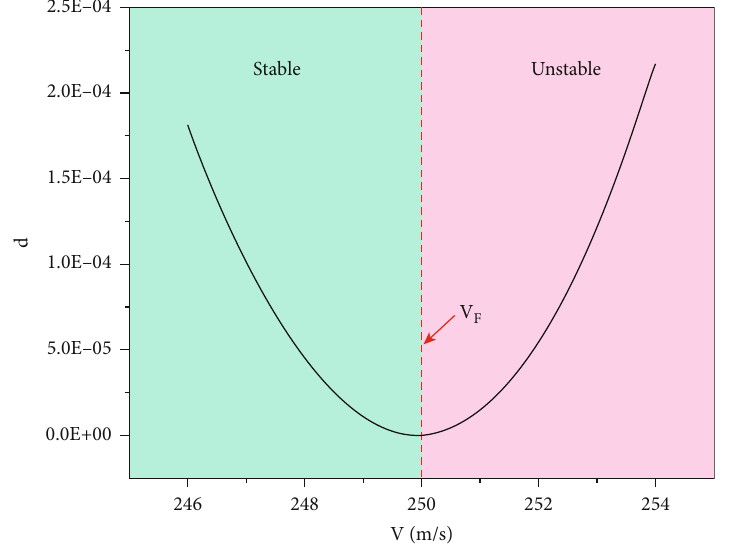
Figure 6: Minimum distance from det D ð V , ω Þ to the origin.